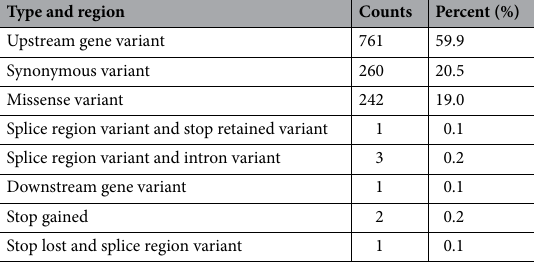
Table 3. The number of SNP effects with different type and region.